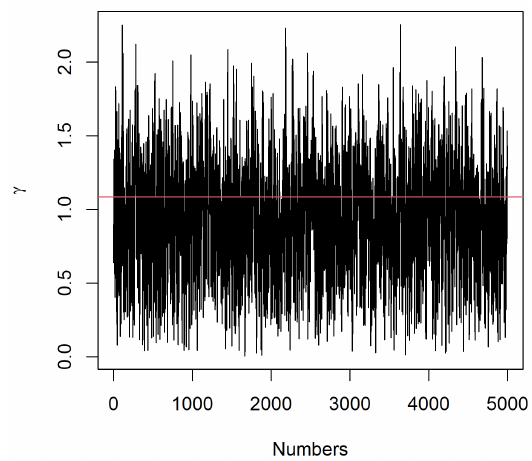
Figure 7. The Markov chains of γ .